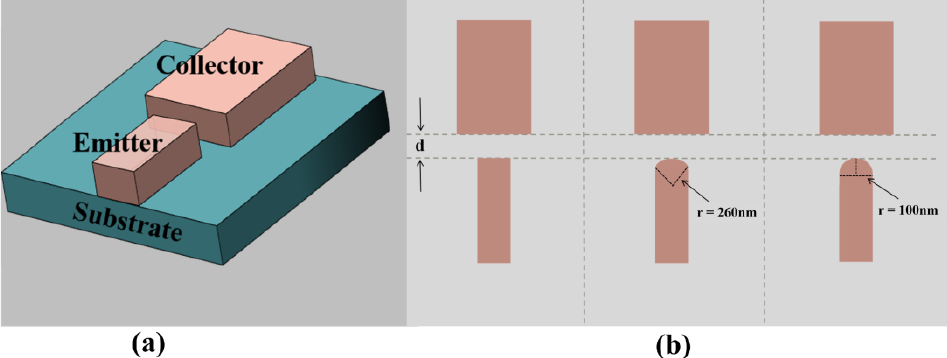
Figure 2. Schematic diagram of the structural model, ( a ) three-dimensional schematic, ( b ) top view of planar-type NVCTs with emitter of flattened electrode, radius of curvature 260 nm, and radius of curvature 100 nm.